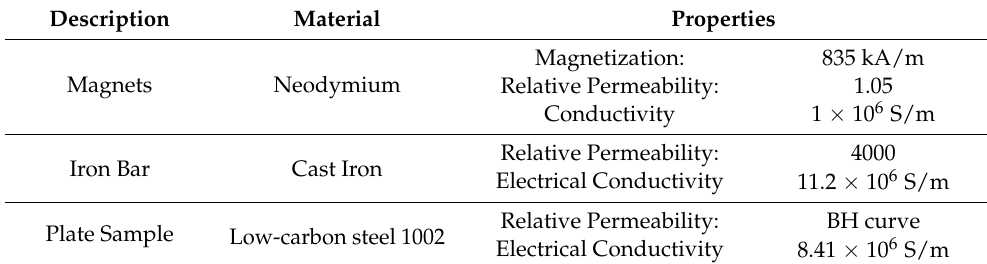
Table 1. The material properties defined in the FE model.